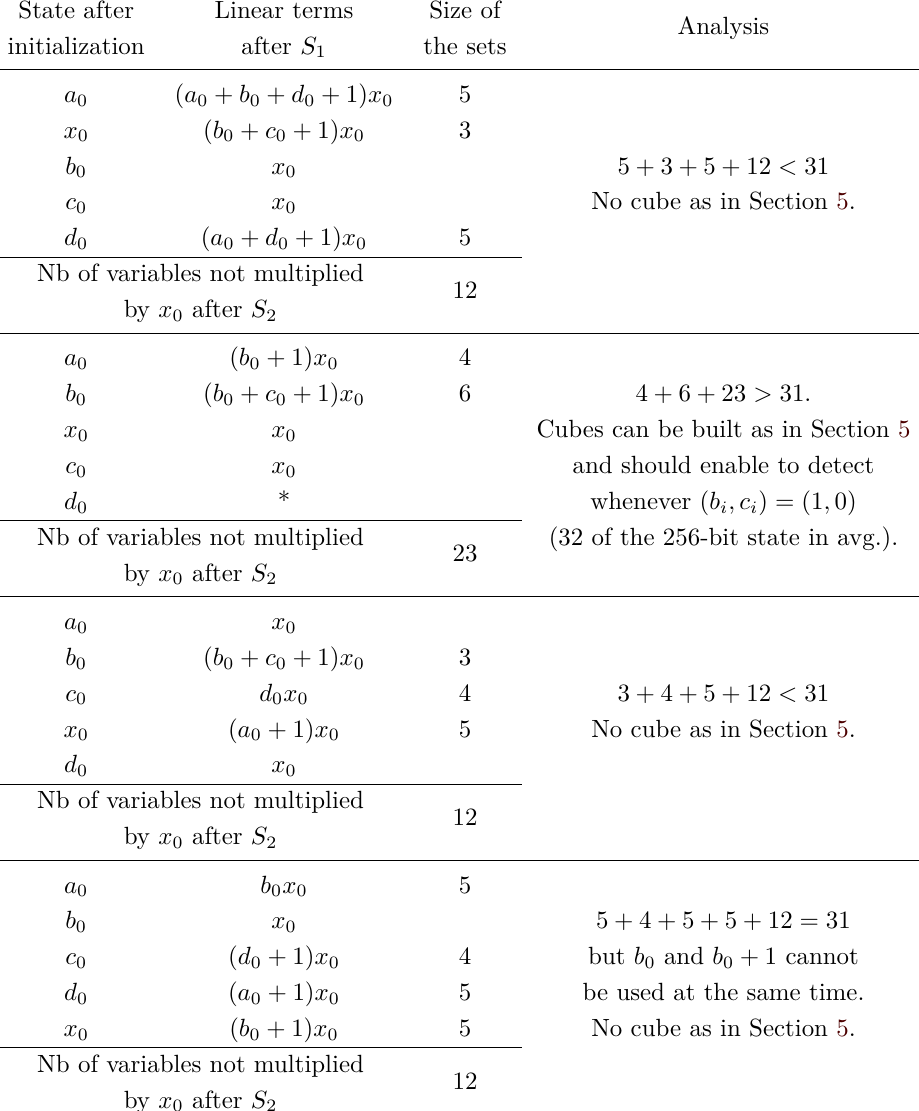
Table 8: A possible counter-measure: changing the public variables input row. The table provides the sizes of the sets corresponding to S instance, the first row in the table states that, for 5 indices i , the coefficients of all x share ( a + b + d + 1) as a 0 0 0